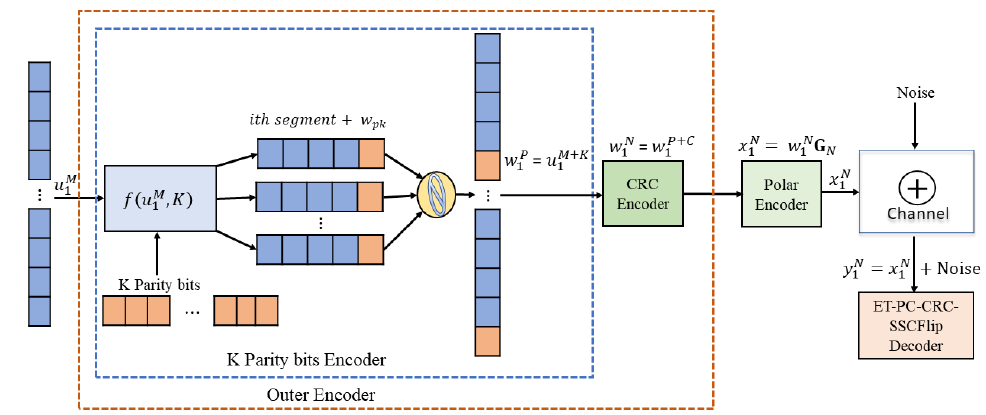
Figure 4. Partitioning of a message vector into equal size segments.